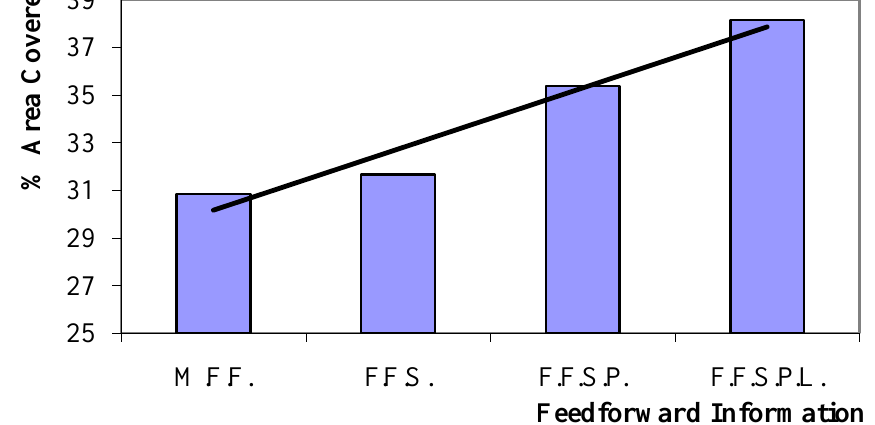
Figure 8. “Area Covered as a Function of Amount of Feedforward Information Provided”. Source. Own